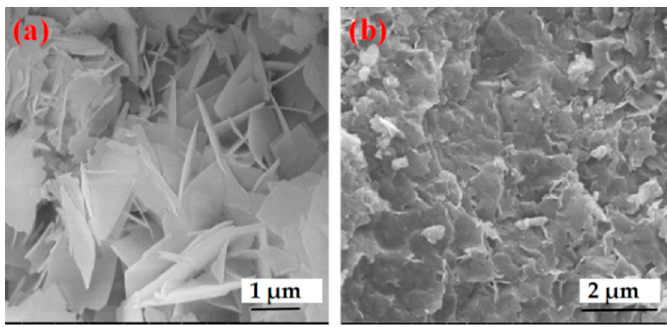
Figure 1. SEM images of ( a ) Cu(Im) 2 and ( b ) Cyt c @Cu(Im) 2 .